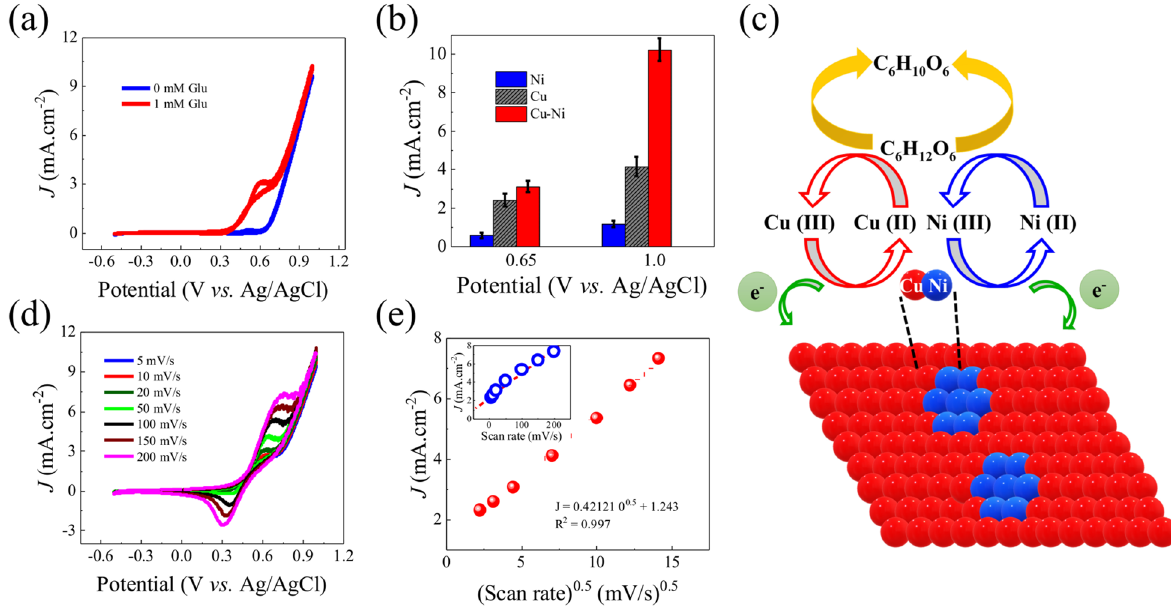
Figure 2. Glucose sensing characteristic of electrodes: ( a ) CV of Cu–Ni thin film electrode in the presence of 1 mM glucose concentration compared with the CV of no glucose concentration, ( b ) comparison of the glucose oxidation current at 0.65 and 1.0 V for three electrodes, ( c ) Schematic illustration for electrocatalysis of Cu–Ni for glucose oxidation, ( d ) CVs of Cu–Ni thin film electrode at different scan rates from 5 to 200 mV s −1 in 0.1 M NaOH with 1.0 mM glucose, ( e ) glucose oxidation current versus square root of scan rate fitted with a straight line and inset of ( e ) shows oxidation current versus scan rate for comparison.